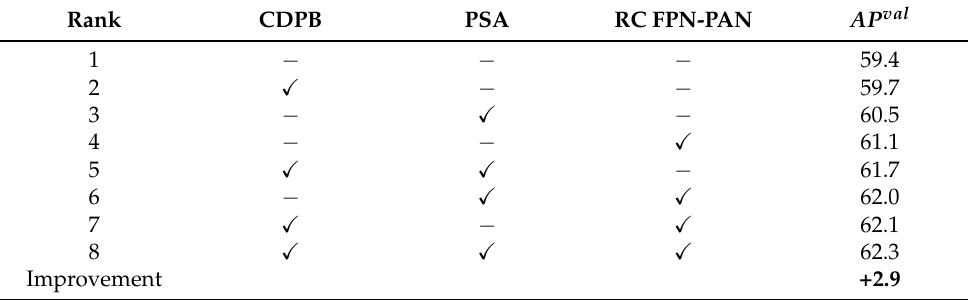
Table 7. Results of ablation experiments with improved structures.